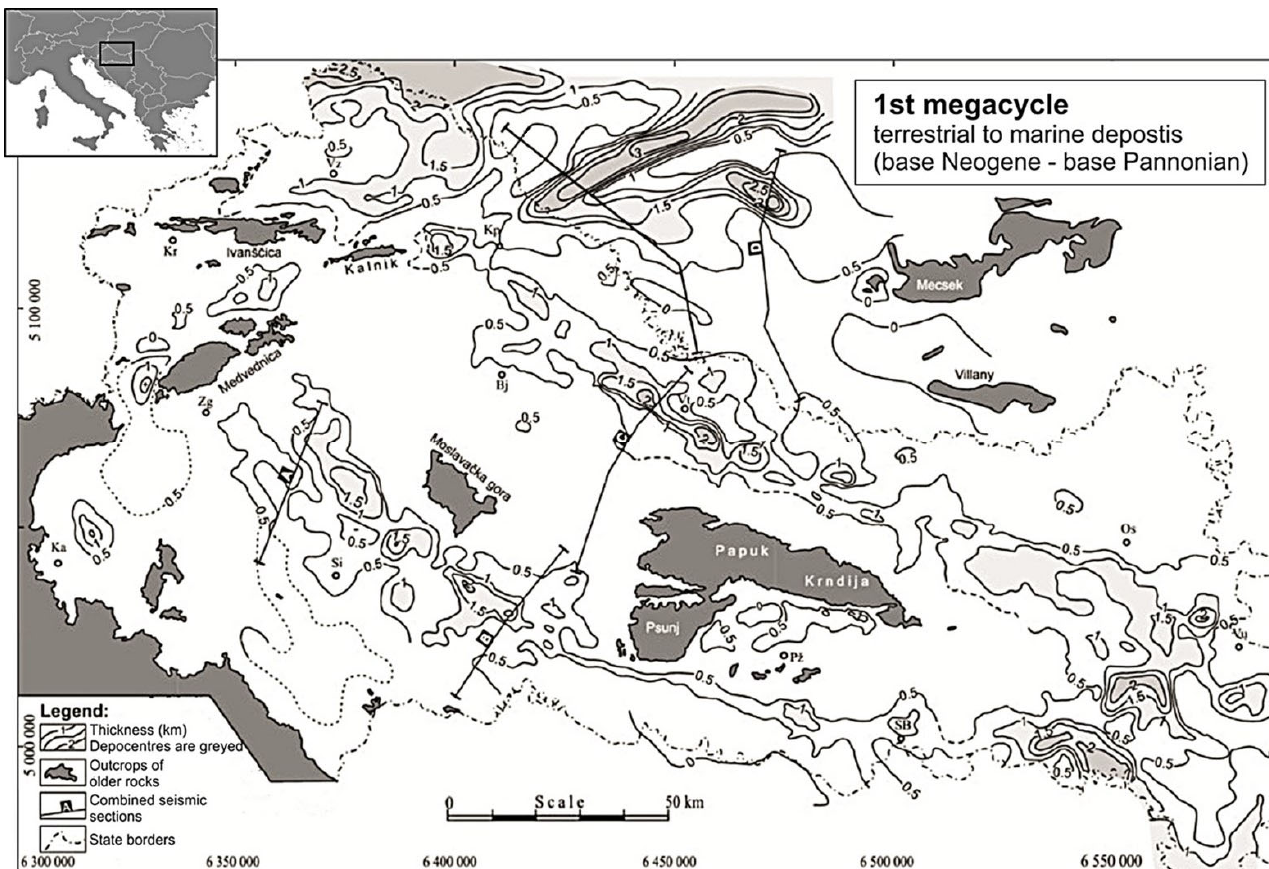
Figure 7. Isopach (thickness) map of the 1st megacycle (Lower − Middle Miocene) in the Pannonian Basin. Depocenters, situated in the deepest depressions, are marked by light grey color. A, B, C and D lines show the position of seismic sections [10].